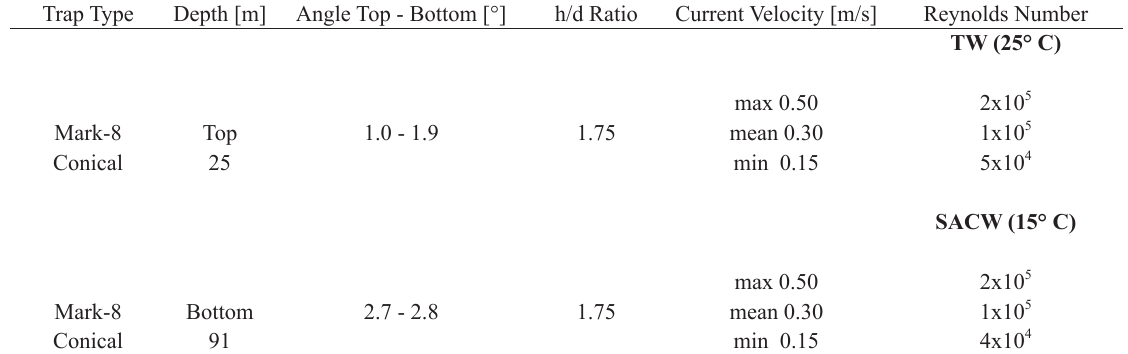
Trapping efficiency of the sediment trap evaluation. Abbreviations: h, height of the trap; d, top diameter of the